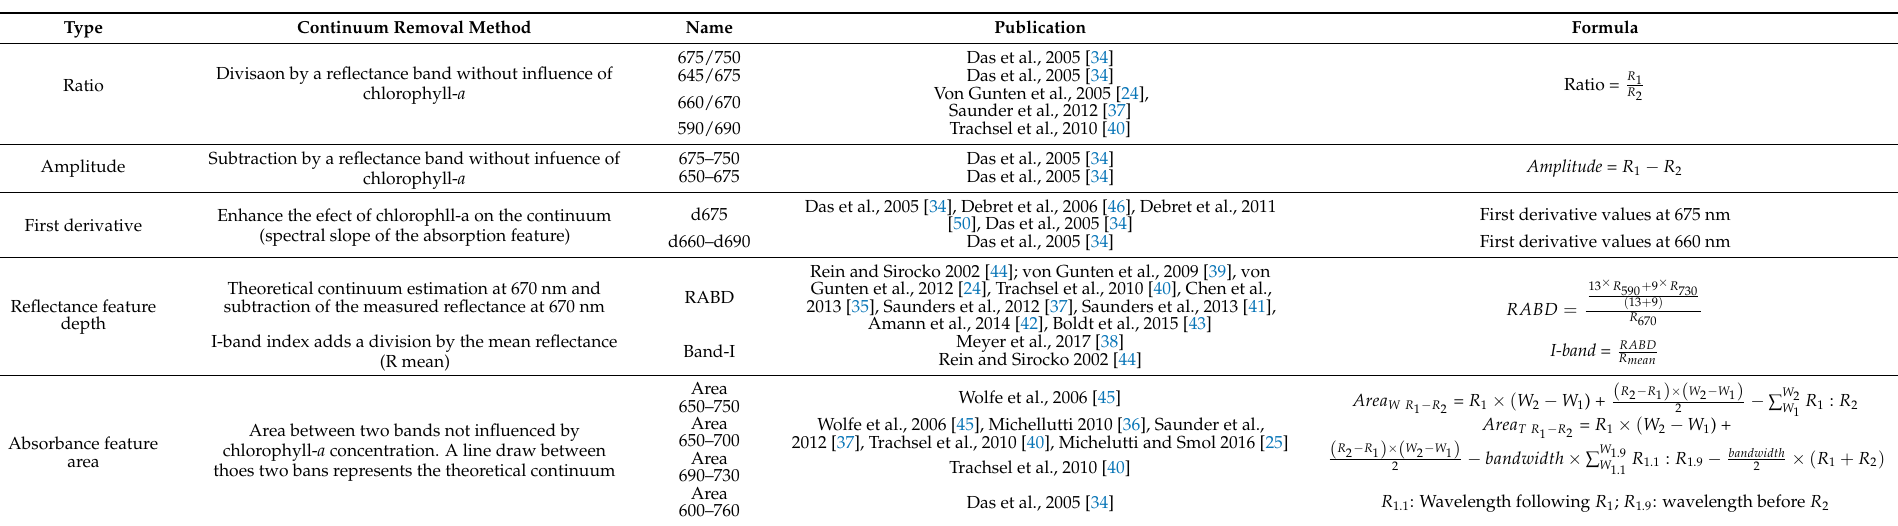
Table 1. Synthesis of the various indices used in publications to reconstruct chlorophyll and by products